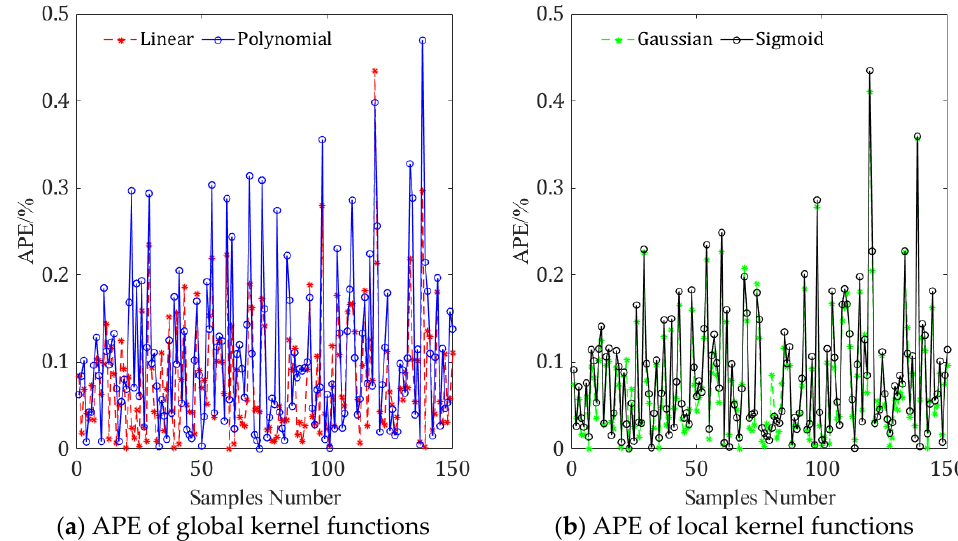
Figure 9. APE of forecasted calorific value ( Q b,ad ) based on a single kernel function.